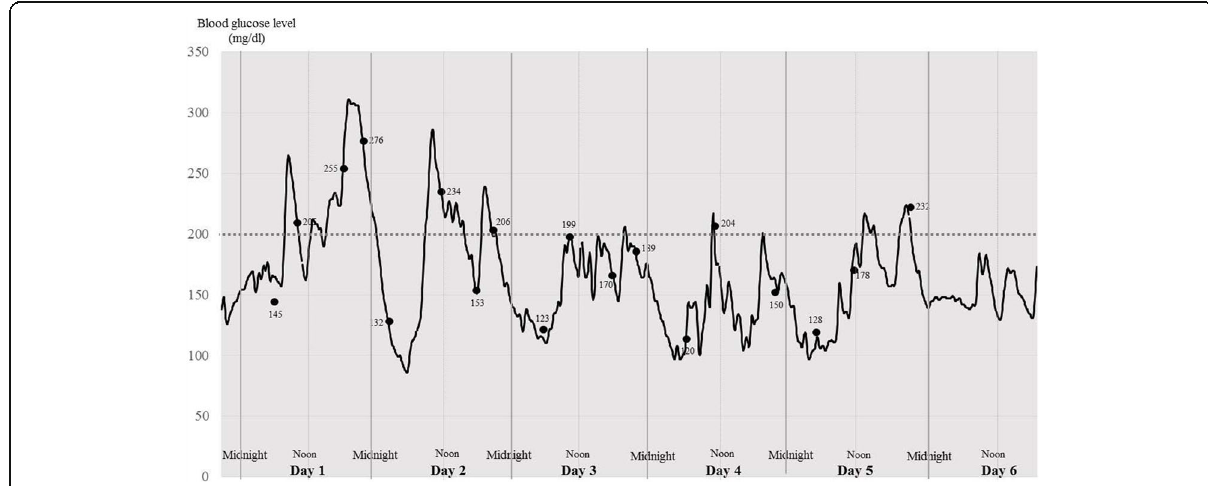
Fig. 1 Continuous blood glucose trace for Patient 1. Postoperative blood glucose concentrations in an 81-year-old woman with pre-diabetes in whom a bilateral total knee arthroplasty (TKA) had been performed. X-axis, postoperative day; Y-axis, blood glucose concentration (mg/dl). Black spots, blood glucose concentrations measured using self-monitoring of blood glucose (SMBG). Each number is the blood glucose concentration (mg/dl) at that time